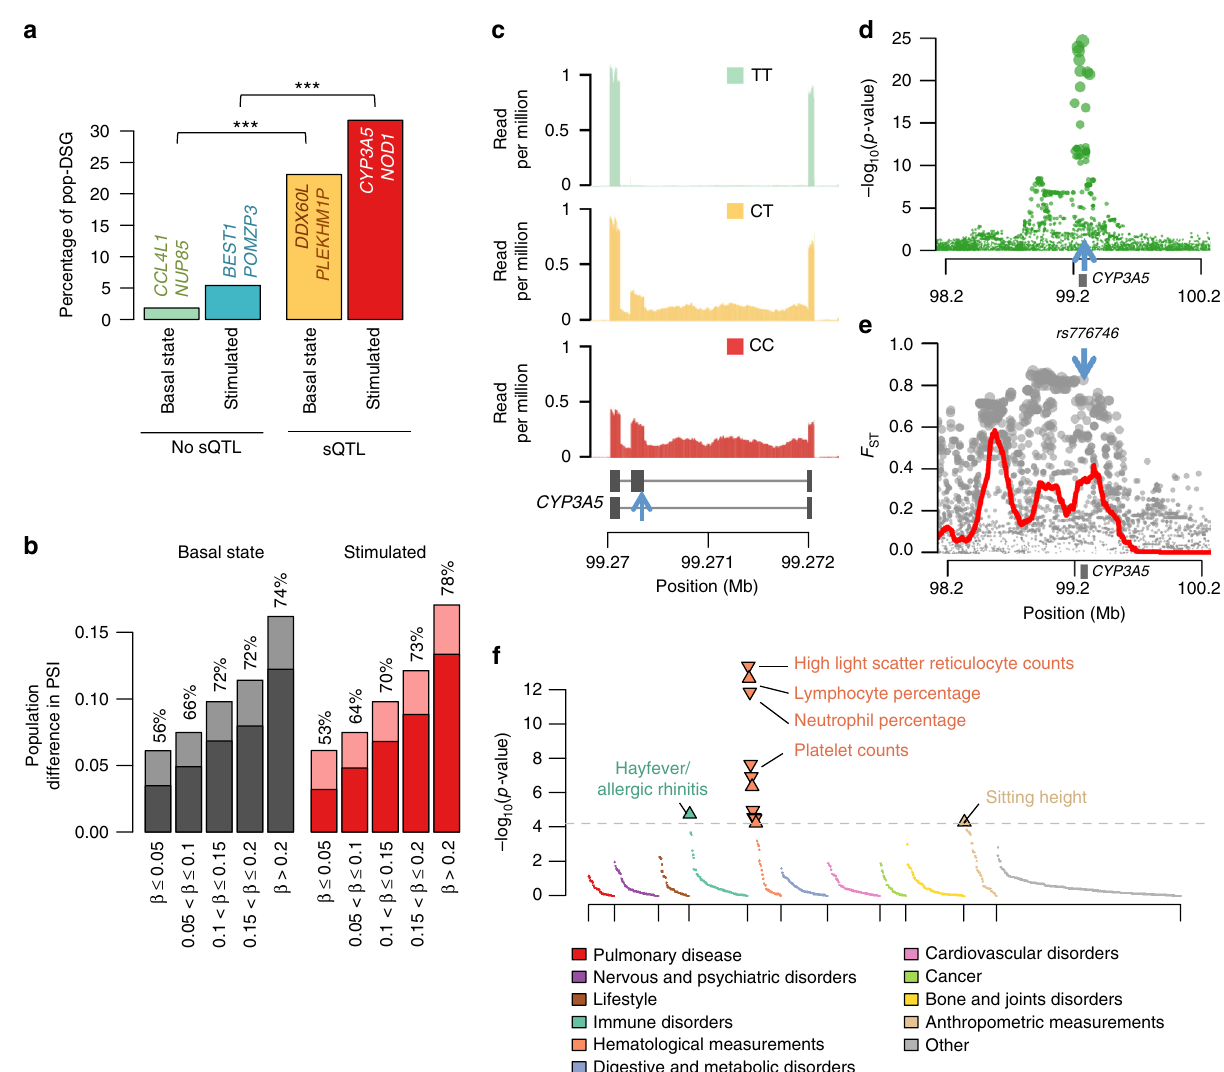
Fig. 6 Population differences in alternative splicing and impact of positive selection. a Percentage of genes showing differential splicing between populations (pop-DSG) at the basal state and after stimulation, classi fi ed according to the presence of a sQTL (Fisher ’ s exact test for equal proportion, *** p < 10 − 20 ). For each group, examples of genes that present the strongest population differences are reported. For the stimulated state, the reported genes are chosen among those that are differentially spliced speci fi cally after stimulation. b Contribution of genetic factors to the detected population differences in splicing patterns. The mean difference in PSI value between populations is represented, at the basal state (grey) and after stimulation (red), for genes presenting an sQTL with various levels of effect size ( β ). For each group, the average difference in PSI value that is mediated by the sQTL is shown in dark shade, and the corresponding percentage is indicated above the bar. c The derived allele (C) of the sQTL rs776746 (blue arrow) is associated with the inclusion of an additional exon at the CYP3A5 gene. d Association between SNPs in a 2 Mb window around the sQTL rs776746 and splicing levels of CYP3A5 in the Pam 3 CSK 4 condition. e Signals of positive selection around the CYP3A5 locus, measured by the F ST metric. The red curve shows the proportion of SNPs with extreme F ST values (>95% percentile), in a 100 kb window around each SNP. f Phenome-wide association study of the SNP rs776746, based on 778 phenotypic traits measured by the UK biobank study 63 . The dashed line indicates the Bonferroni-corrected signi fi cance threshold. For signi fi cantly associated traits, arrows indicate the direction of the effect of the derived allele ( c ). Source data are provided as a Source Data fi